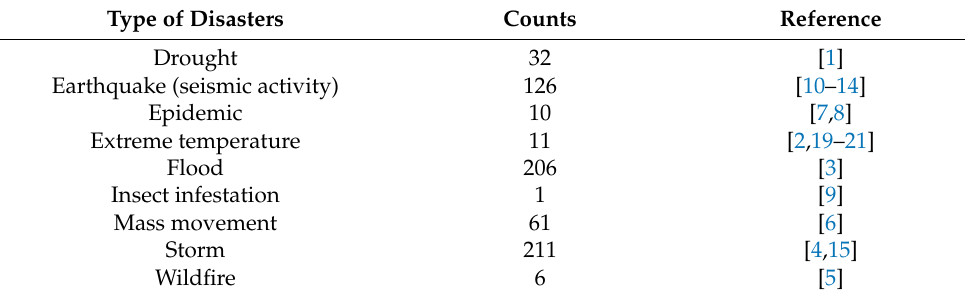
Table A1. The types and counts of climate-related natural disasters used for analysis in this